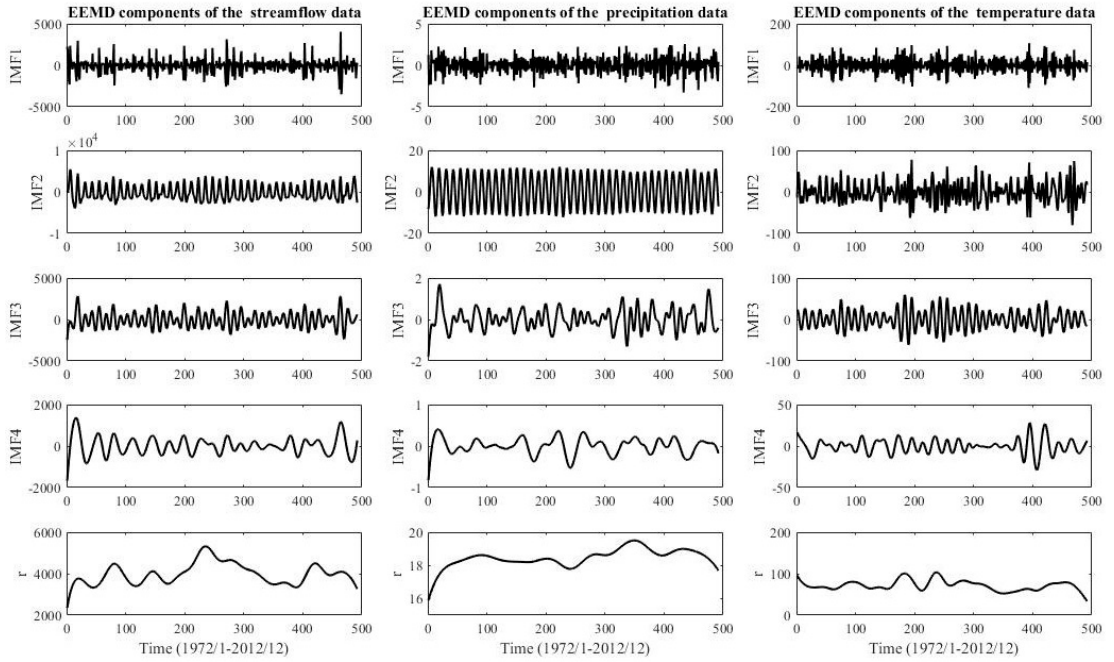
Figure 9. Zone Three: streamflow, precipitation, and temperature data are decomposed by EEMD.